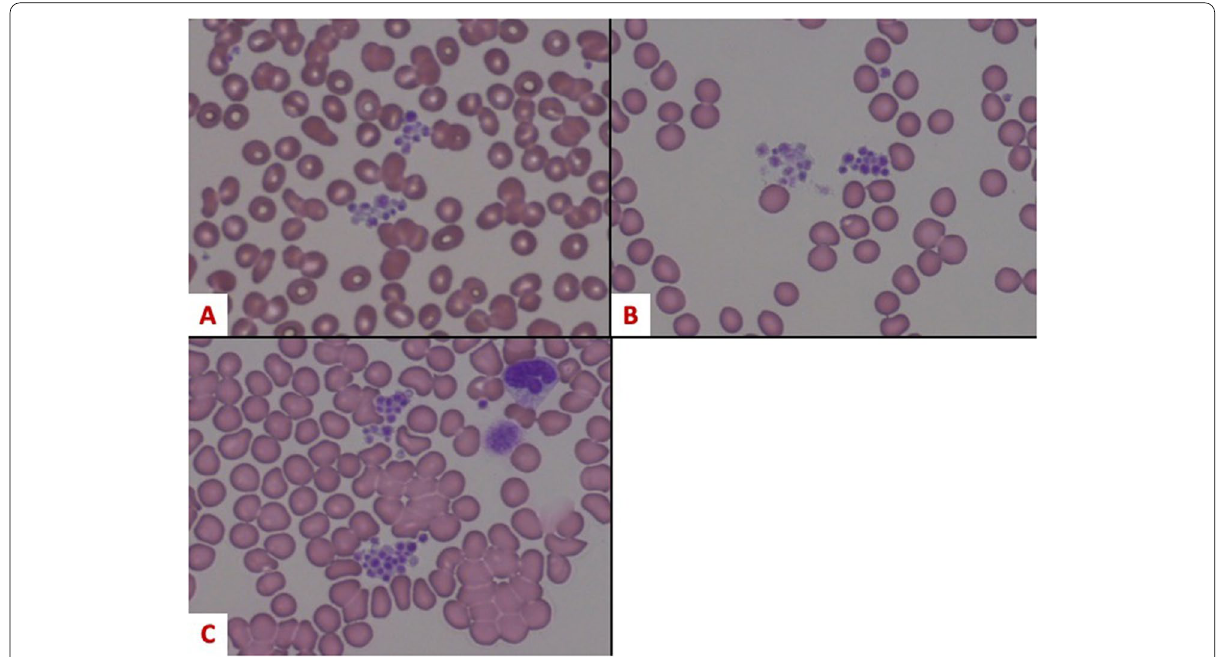
Fig. 1 Aggregation of platelets in specimen tubes collected. The preoperative peripheral blood smear showed platelet agglutination in all specimen tubes collected ( A ethylenediaminetetraacetic acid, B acid citrate dextrose, C